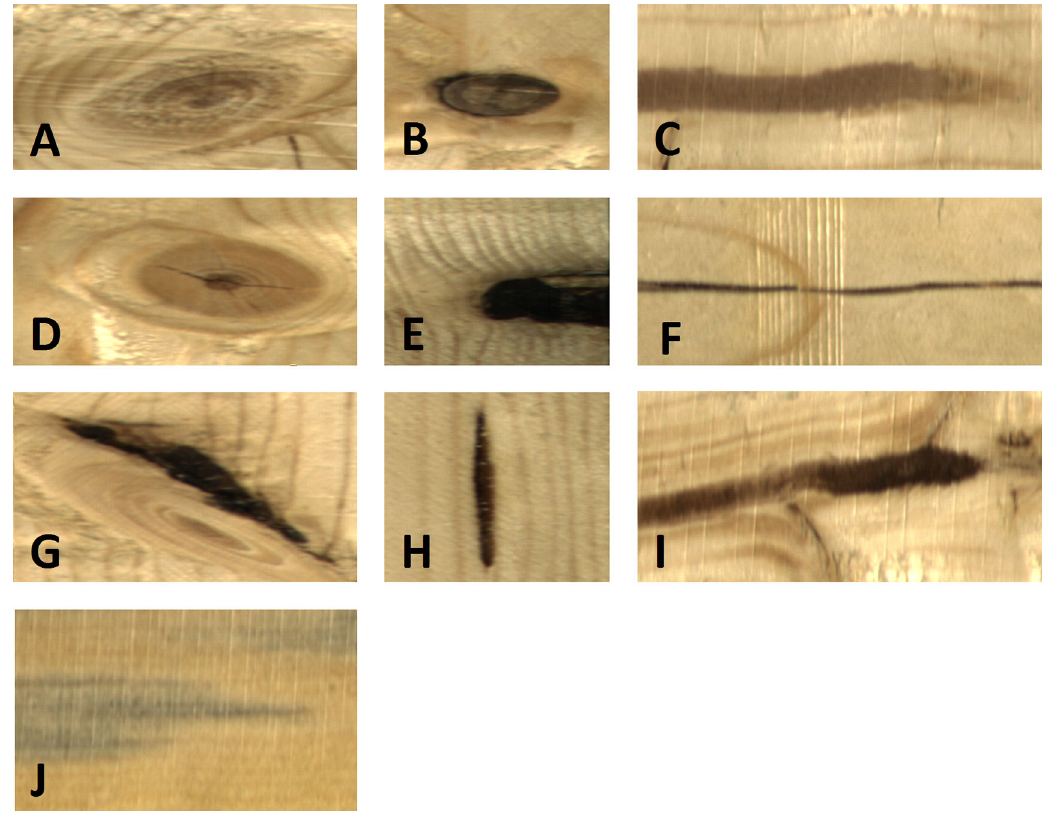
Figure 4. Typical samples of wood defects within the dataset: (A) Live Knot, (B) Dead Knot, (C) Quartzity, (D) Knot with crack, (E) Knot missing, (F) Crack, (G) Overgrown, (H) Resin, (I) Marrow (J) Blue